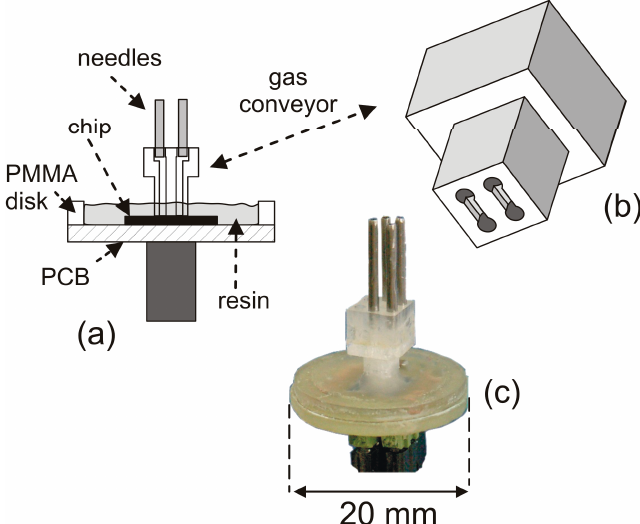
Figure 2. ( a ) Schematic view of the sensor after packaging; ( b ) perspective view of the gas conveyor showing the trenches milled onto the face that is applied to the chip; ( c ) photograph of the finished sensor.